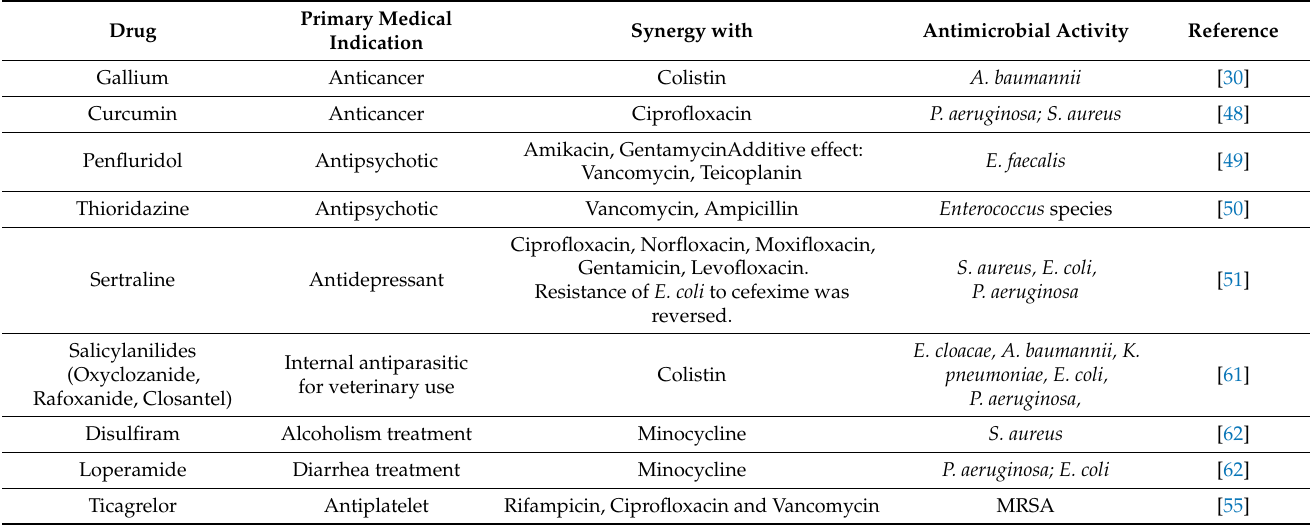
Table 2. “Nonantibiotic” approved drugs that synergize with antibiotics towards MDR